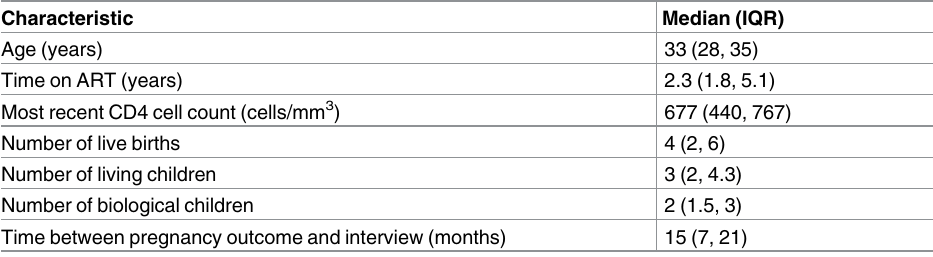
Table 1. Socio-demographic characteristics of women living with HIV who had a pregnancy within 2 yearsprior to interview (n =